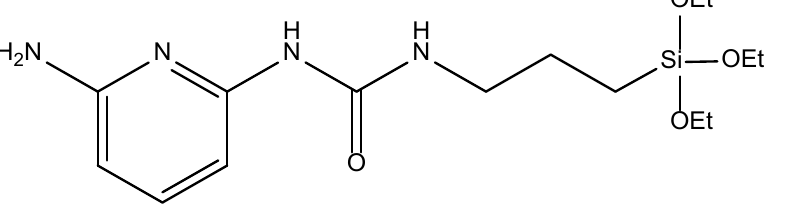
Figure 2. Chemical formula of the 1-(6-aminopyridin-2-yl)-3-(3-(triethoxysilyl)propyl)urea (silylated aminopyridine, py).